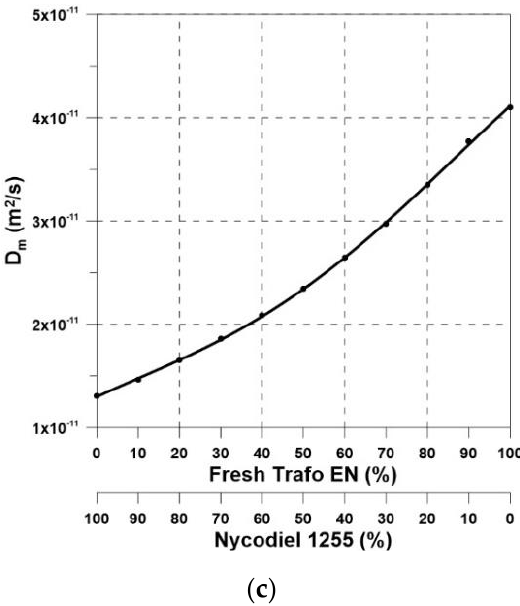
Figure 2. ( a ) Density, ( b ) kinematic viscosity and ( c ) molecular diffusion coefficient vs. mixing of Nycodiel 1255 synthetic ester with fresh Trafo EN mineral oil.